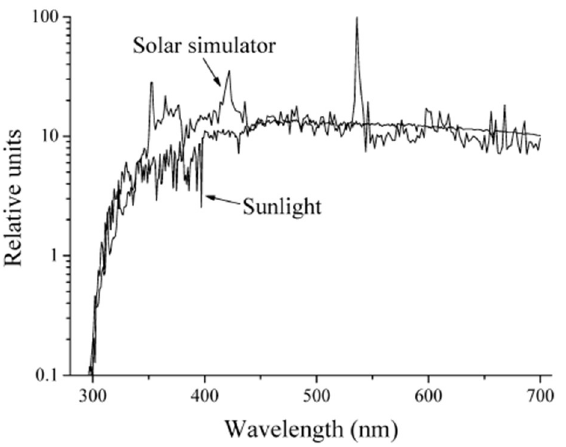
Figure 1. The emission spectrum of the solar simulator which provides culture